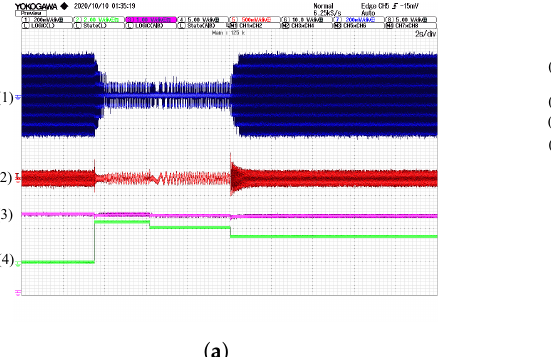
Figure 19. Experimental result when speed is varied for the 9-level inverter: ( a ) ( 1 ) Phase voltage (y-axis: 20 V/div), ( 2 ) phase current (y-axis: 5 A/div), ( 3 ) torque (y-axis: Nms), ( 4 ) speed reference (y-axis: 3600 RPM/div). ( b ) ( 1 ) Phase voltage (y-axis: 20 V/div), ( 2 ) phase current (y-axis: 5 A/div), ( 3 ) torque (y-axis: Nm), ( 4 ) speed reference (y-axis: 3600